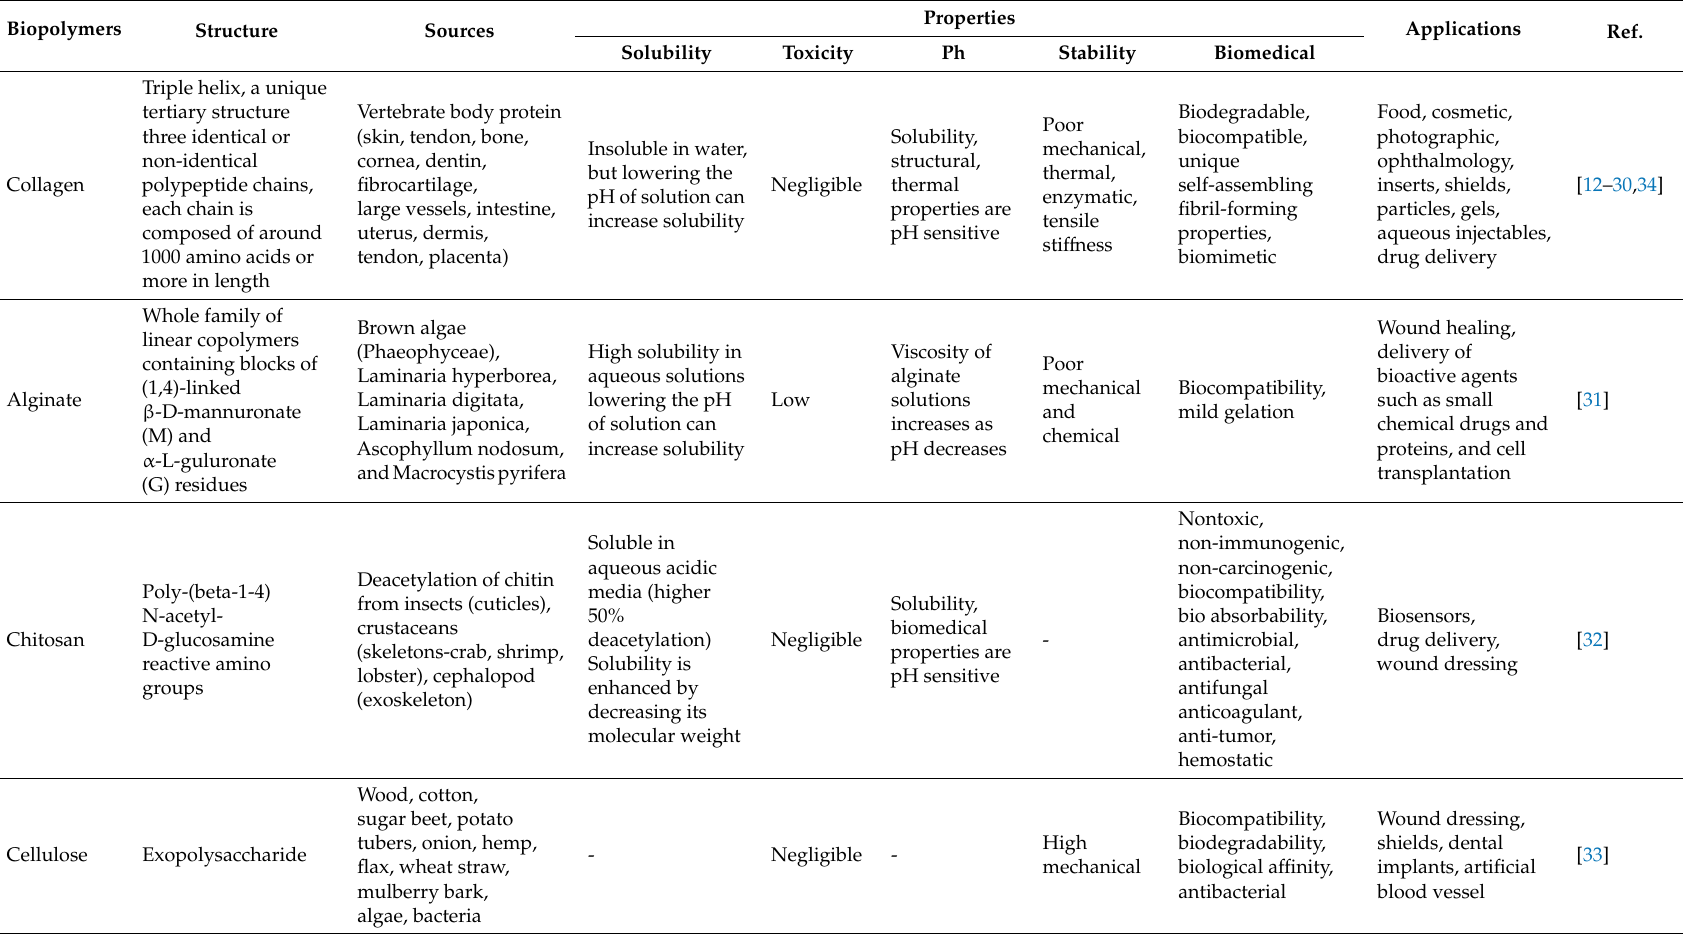
Table 1. Biopolymers structures, sources, properties, and potential